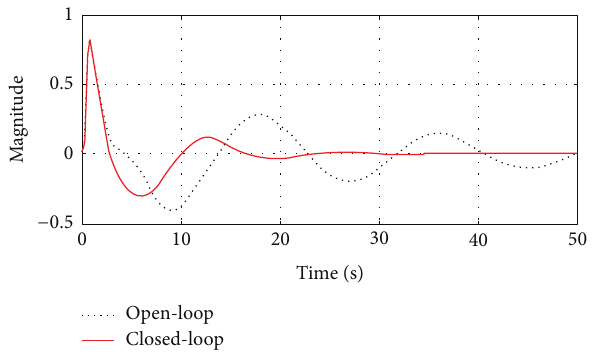
Figure 4: The responses of state variable 𝑥 3 (𝑡) .